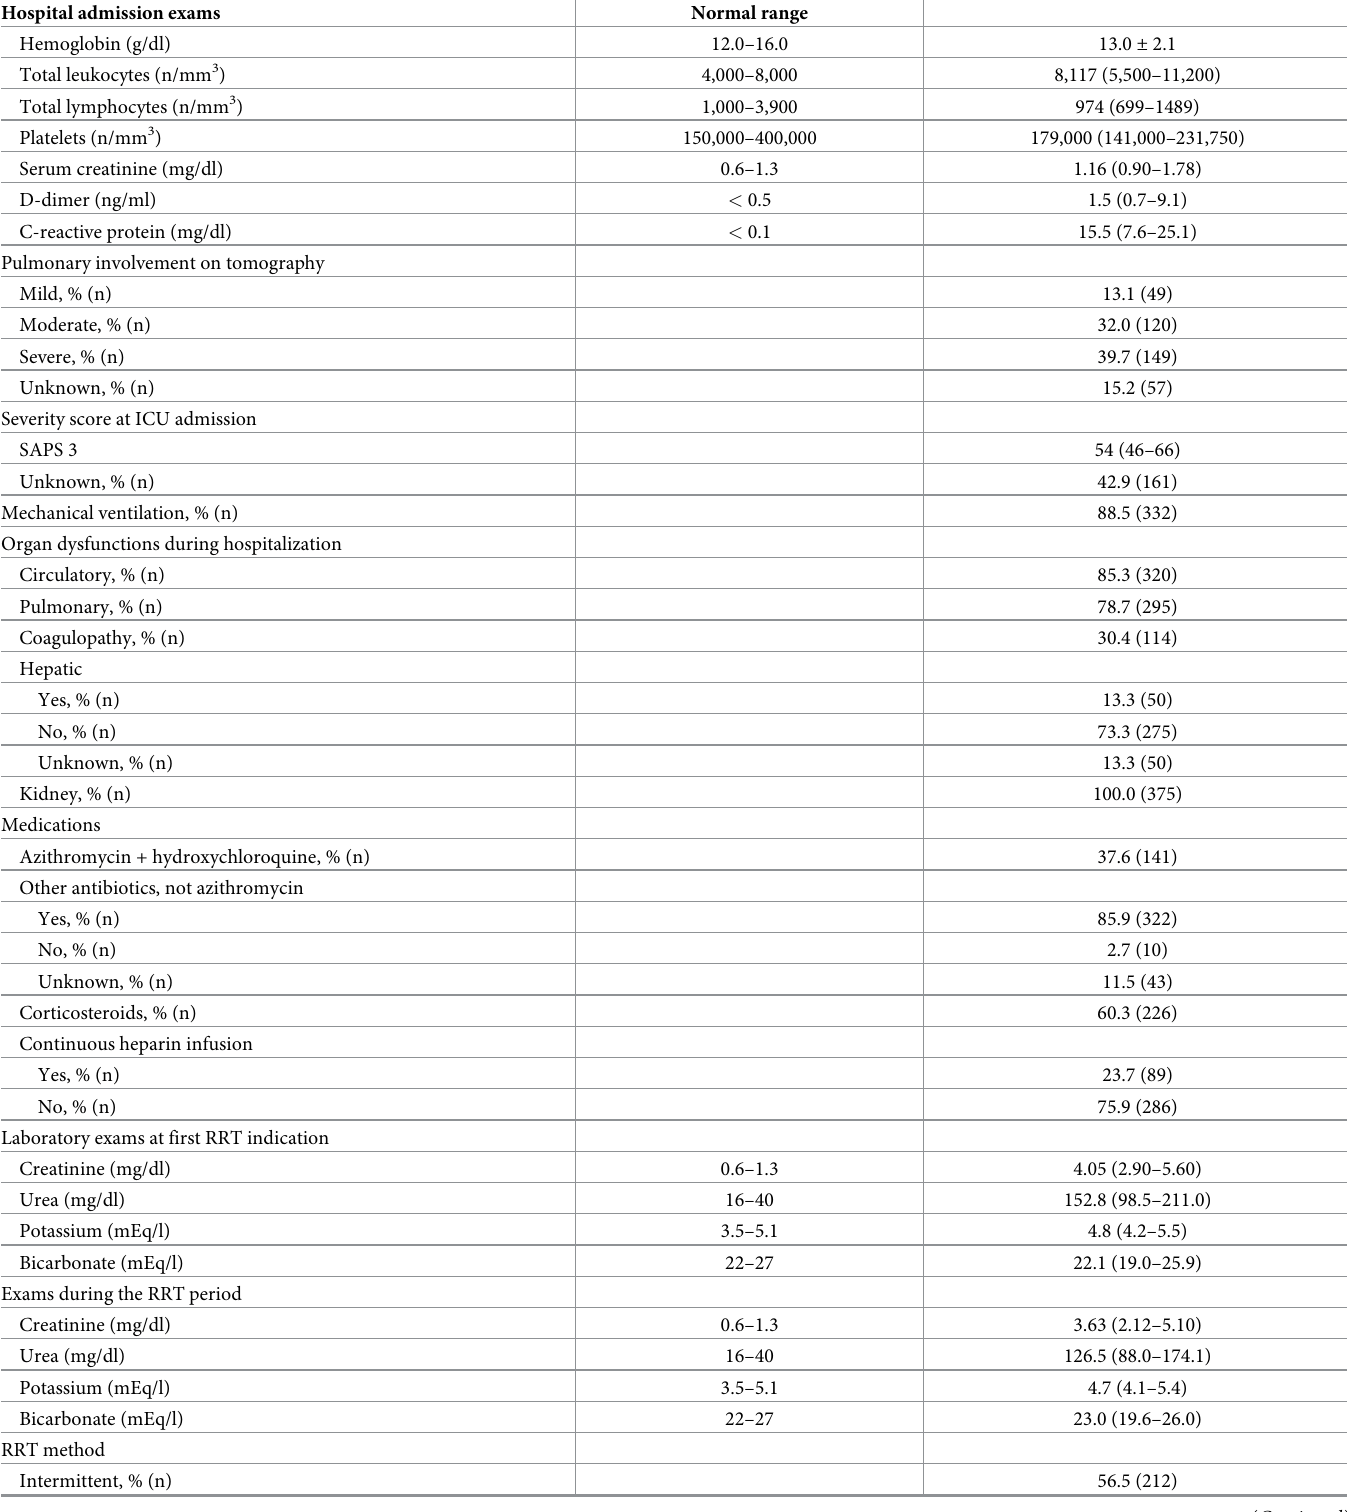
Table 2. Subsidiary test results, clinical characteristics, and outcomes of the patients included in the study (N =